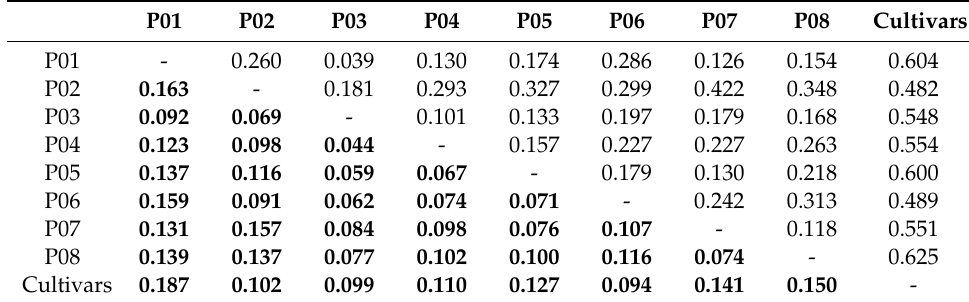
In bold, significant F ST values with p ≤ 0.05, calculated over 999